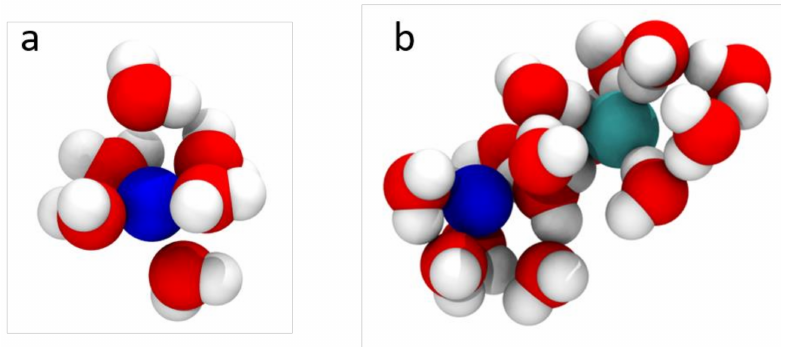
Figure 2. ( a ) Na + ion (blue) solvated with water (red/white) to effectively increase its size; ( b ) A hydrated ion pair of Na + (blue) and Cl − ions